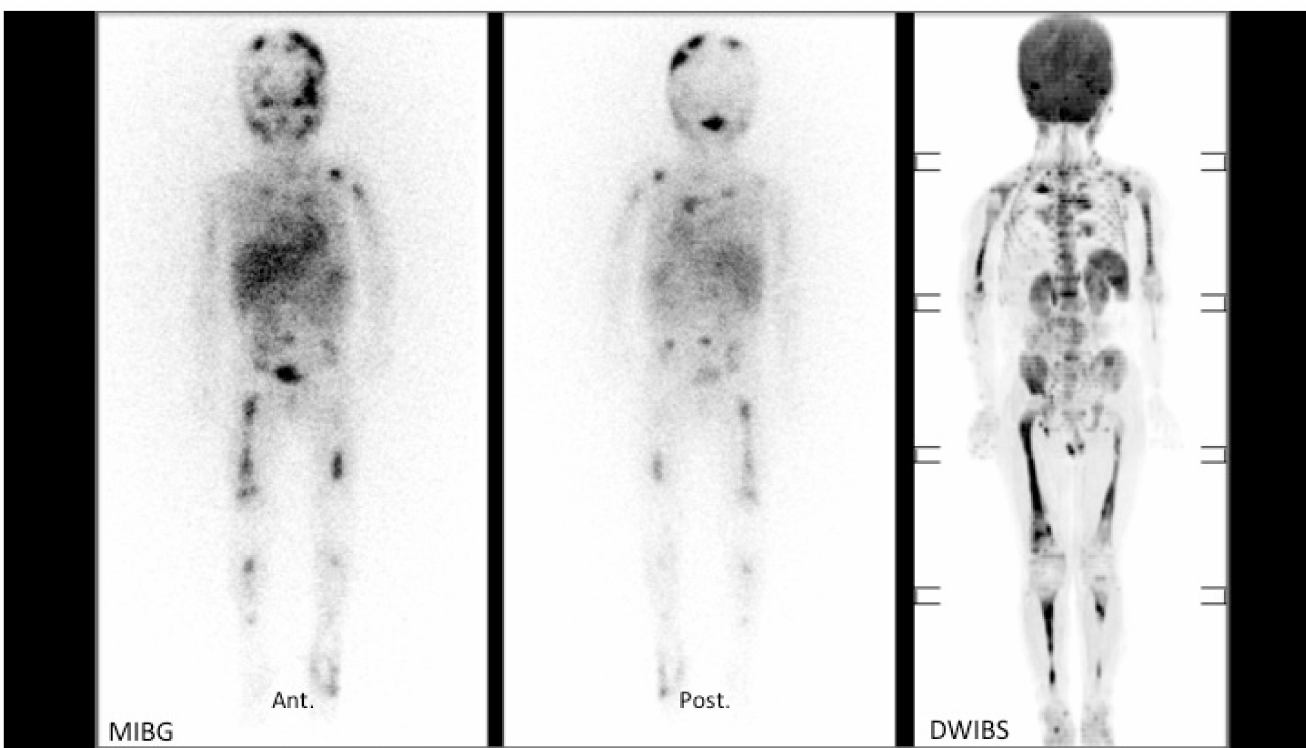
Figure 2. Correlation example of positive bone lesions by 123 I-Metaiodobenzylguanidine (MIBG) and diffusion-weighted (DW) Magnetic Resonance Imaging (MRI) for patient #9 (Table 1) before chemo-immunotherapy treatment. Left (anterior view) and middle (posterior view) panels: positive MIBG in multiple skeleton bones. Right panel: areas of restricted diffusion on a Coronal 3D reconstructed DW- MRI imaging (DWIBS) of the same patient. Note the limitation of skull bone involvement evaluation on DWIBS compared to